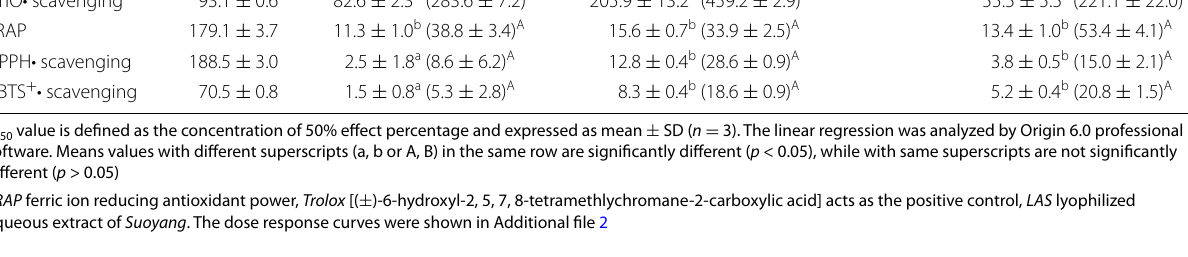
Table 2 The IC values of LAS, epicatechin, luteolin-7-O-β-D-glucoside in various antioxidant assays 50